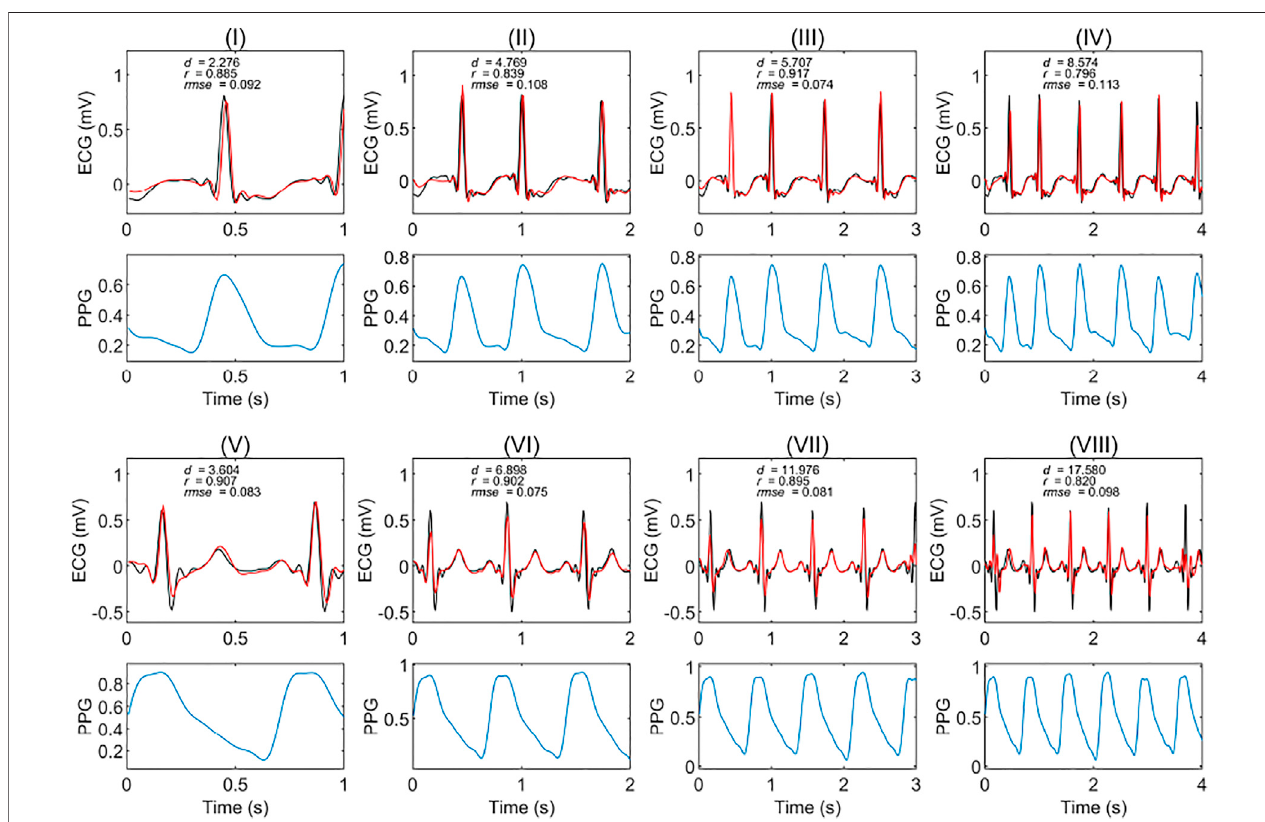
FIGURE 3 | Extracts of experimental results in patients with and without circulatory disease. The red and black curves are the reconstruction ECG and reference ECG, respectively. The abbreviations r , rmse , and d are the Pearson ’ s correlation coef fi cient, root mean square error, and dynamic time warping distance, respectively. (I),(II),(III),and(IV)aretheresultsofasubjectwithacirculatorydiseaseinsegmentsofone,two,three,and4 seconds,respectively.(V),(VI),(VII),and(VIII)aretheresultsof asubjectwithoutanycirculatorydiseaseinsegmentsofone,two,three,and4 seconds,respectively.ThePPGisthecorrespondingsegmentusedtogeneratethe ECG